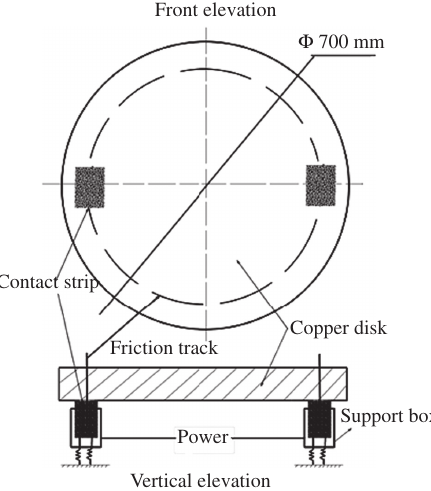
Figure 3 Schematic diagram of wear testing equipment.